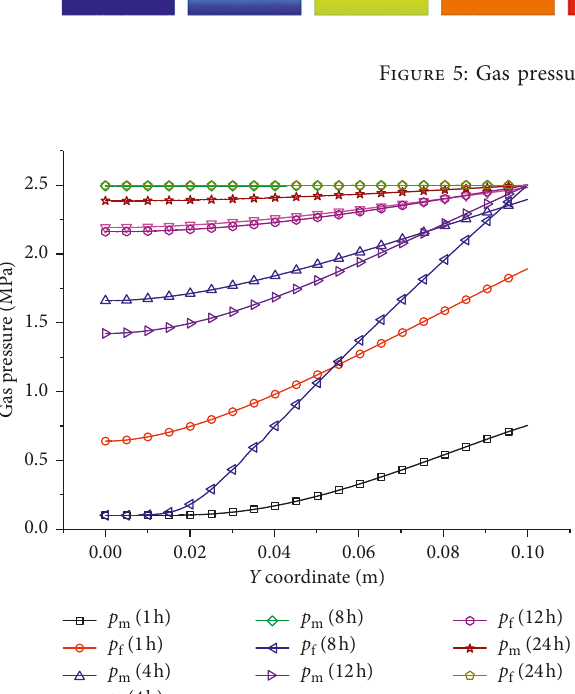
Figure 6: Gas pressure distribution along the monitoring